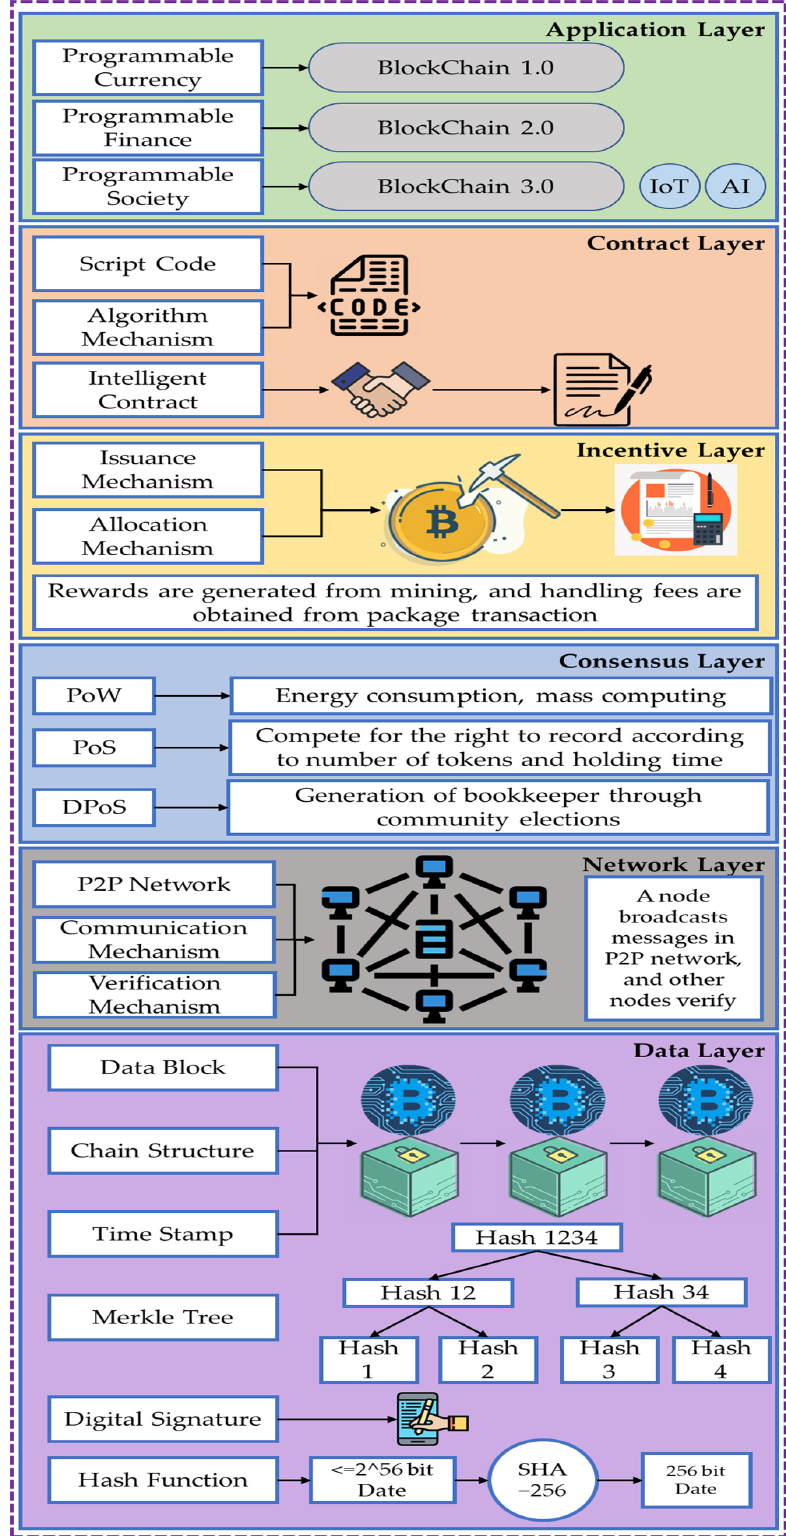
Figure 2. Layered infrastructure of blockchain .